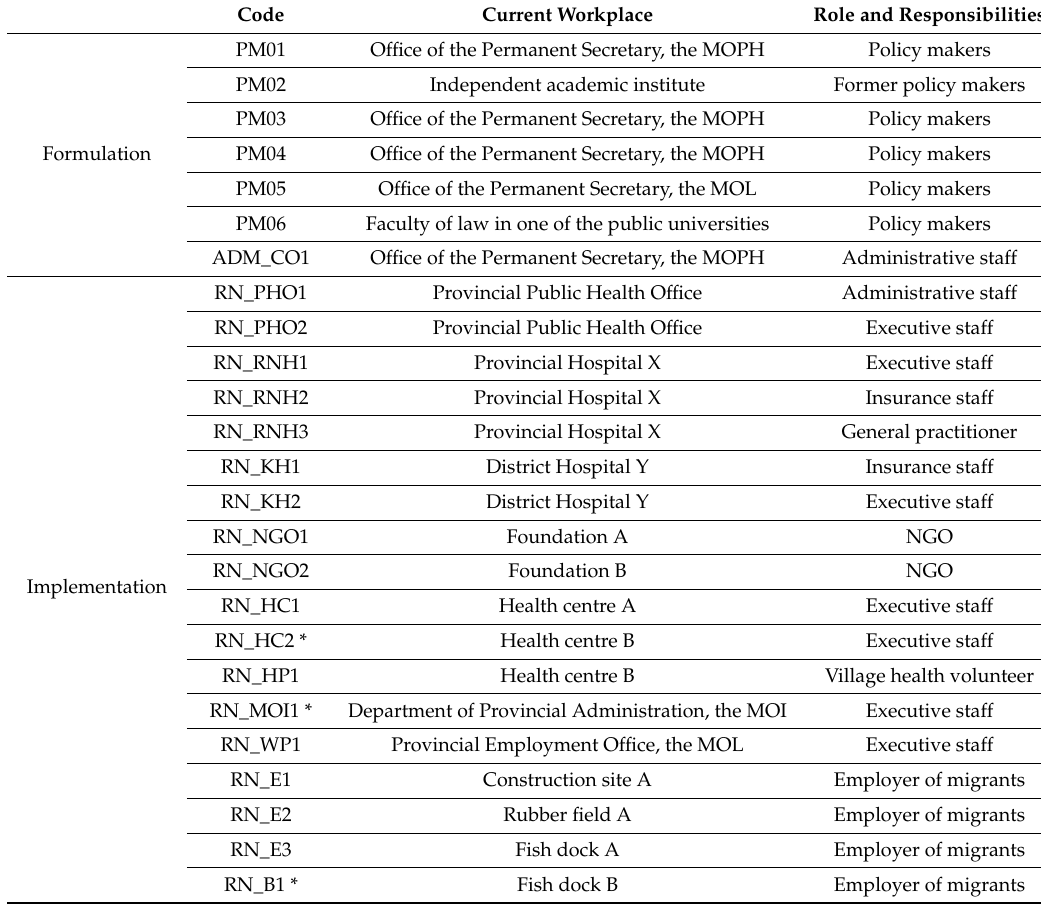
Table 1. Key characteristics of the participants.